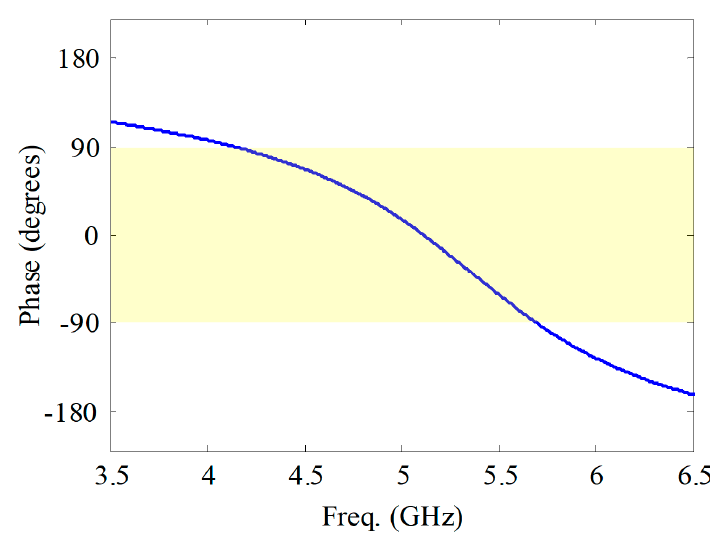
Figure 7. Phase of reflection coefficient of the AMC